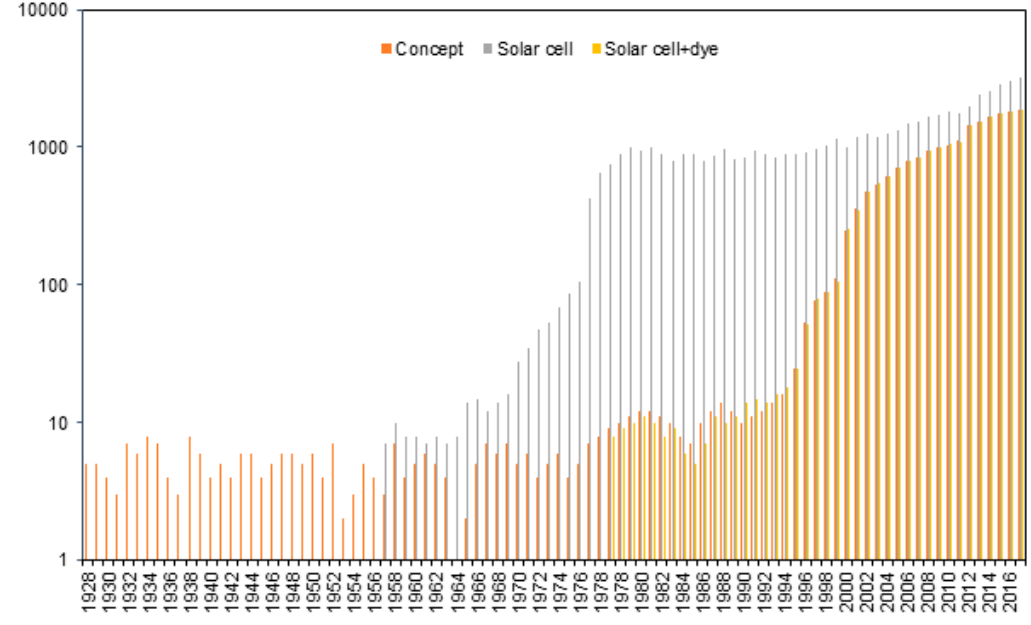
Figure 2. A statistical graph of the number of publications related to the concept of solar cell, solar cell, and dye solar cell. Data were obtained from the Scopus database and Sci Finder.